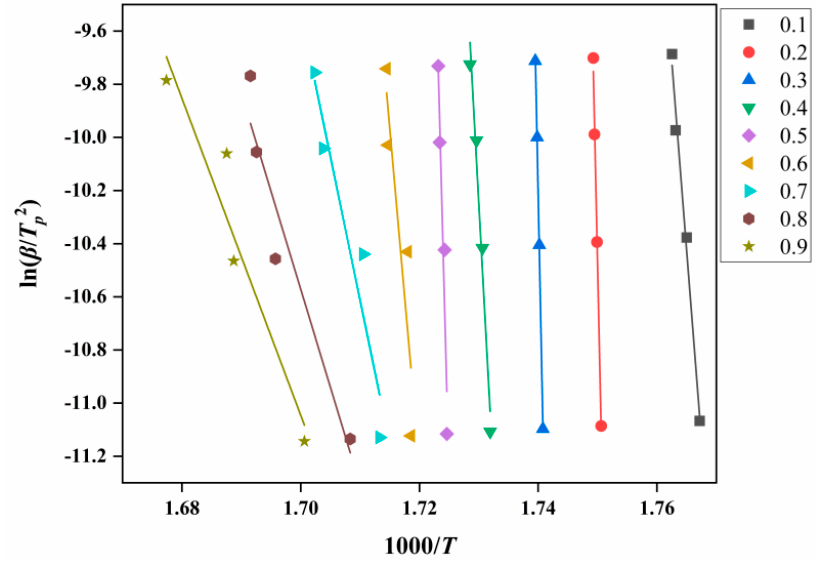
Figure 6. E k analysis diagram of ATRZ determined by the Kissinger method.